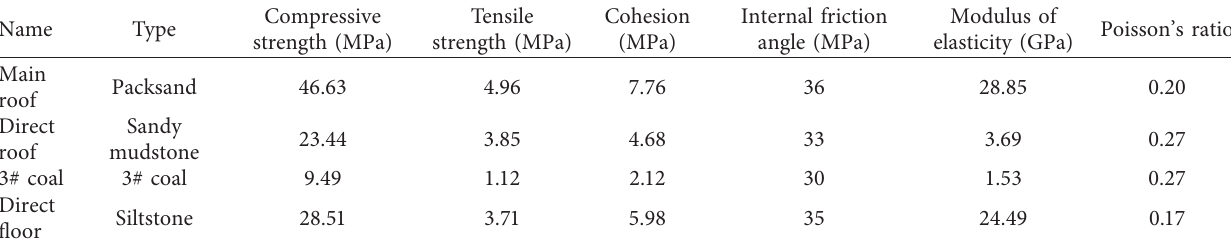
Figure 1: The layout of E1316 working face and Table 1: Mechanical parameters of coal.